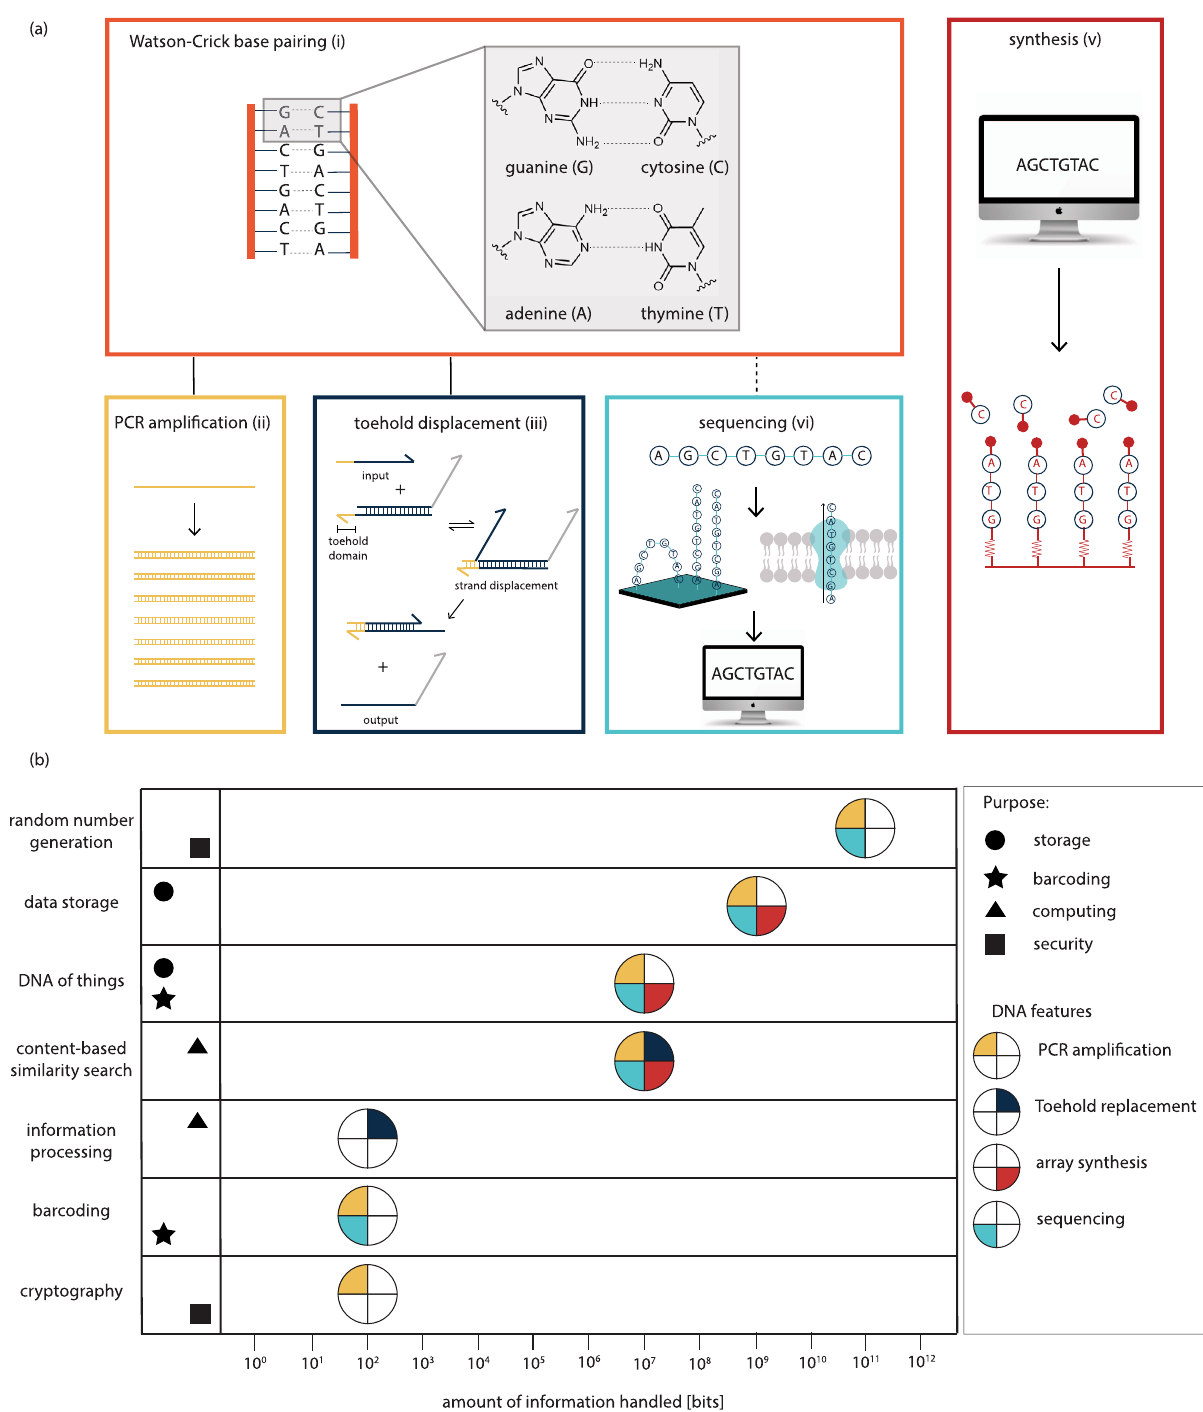
Fig. 1 Unique DNA attributes. a The attributes of DNA make the biomolecule ideal for various computational applications. (i) Watson – Crick base pairing: to allow to predict the connectivity of molecules. (ii) Polymerase chain reaction (PCR) ampli fi cation: to copy a DNA molecule to an exponential multiple. PCR ampli fi cation is based on Watson – Crick base pairing. (iii) Strand displacement: to enable chemical signal processing. This attribute is also based on Watson – Crick base pairing. A single strand input molecule binds to the toehold of the double-strand gate complex and displaces one of the strands to release a single strand output. (iv) Sequencing: to read the information in DNA strands (v) Synthesis: to make new DNA molecules within minutes. b Applications of DNA in information technology and the amount of information described in research literature so far. The attributes of DNA (see a ) that are dominant in the respective applications are color-coded. The purpose of each application is also